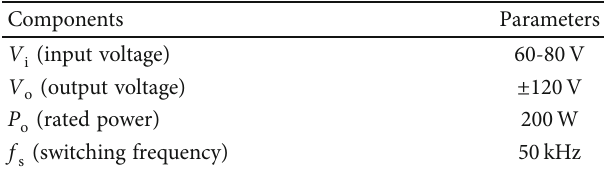
Table 1: Experimental conditions.